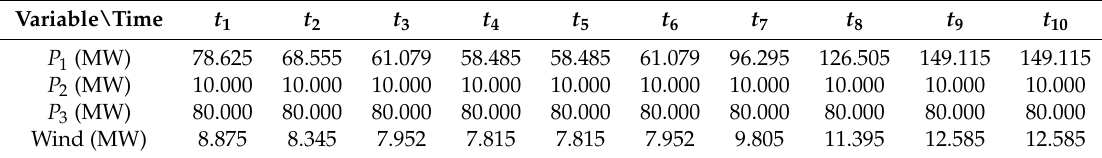
Table 6. Economic dispatch with spatio-temporal scenarios.